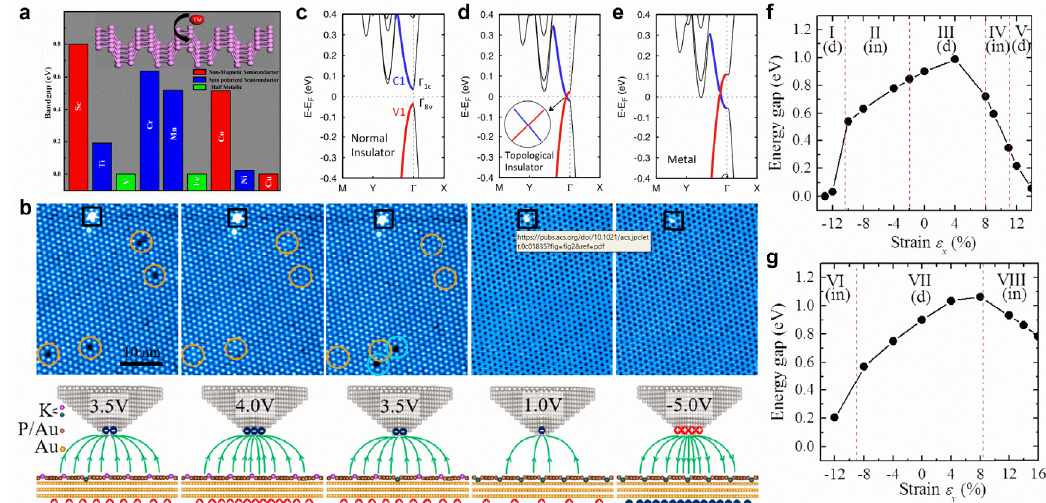
Figure 10. Surface modifications of phosphorene. ( a ) Electronic and magnetic properties of transition-metal-doped phosphorene. ( b ) STM images of blue phosphorene–Au network with 1 ML K deposition scanned with different bias voltages. ( c – e ) Band structures of 4-layer phosphorene with an external electric field of ( c ) 0 V Å − 1 , ( d ) 0.45 V Å − 1 , and ( e ) 0.6 V Å − 1 . ( f , g ) Bandgap of phosphorene as a function of strain: ( f ) ε x , applied in the zigzag and ( g ) ε y , in the armchair directions. ( a ) Reprinted with permission from Ref. [168]. Copyright 2015, American Chemical Society. ( b ) Reprinted with permission from Ref. [173]. Copyright 2020, American Chemical Society. ( c – e ) Reprinted with permission from Ref. [172]. Copyright 2015, American Chemical Society. ( f , g ) Reprinted with permission from Ref. [51]. Copyright 2014, American Physical Society.